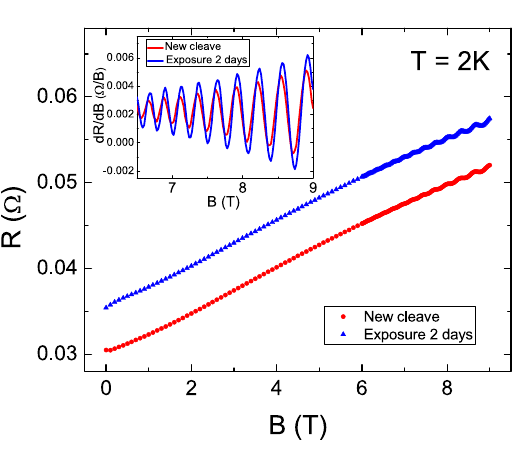
Figure 4. The MR slope as a function of the mobility. The measured data collapses onto one line, demonstrating that the MR slope is proportional to the mobility.